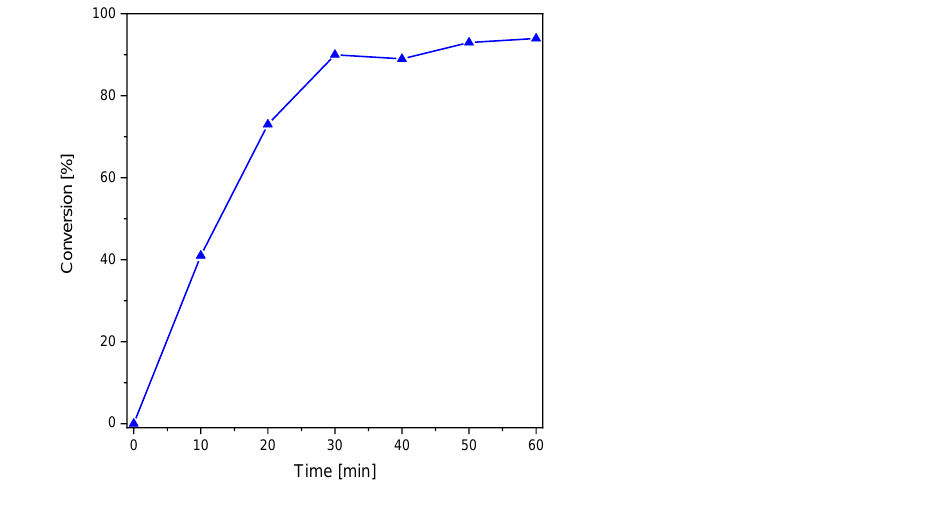
Figure 1. Conversion of S-phenyl thioformate under UV illumination (right, 254 nm, 5.08 mW cm − 2 ).